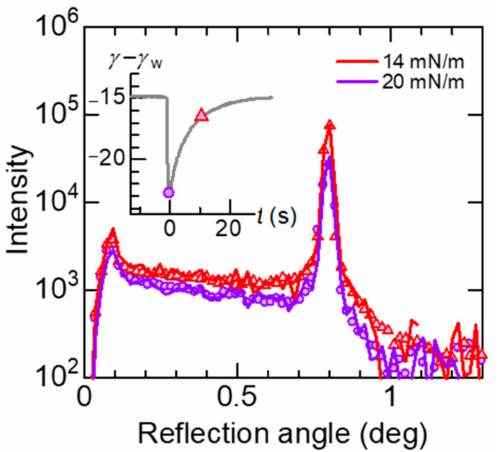
Figure 6. Reflection profiles at α = 0.8 ◦ monitored under the Marangoni flow compared to the profiles without Marangoni flow. The corresponding spontaneous oscillation of surface tension is shown in the inset. The reflection profile at the minimum surface tension (the purple circles) is similar to the profile at the static surface pressure of 20 mN/m (the purple curve), while the profile at which the recovering surface tension (the red triangles) is similar to the profile at the surface pressure of 14 mN/m (the red curve).